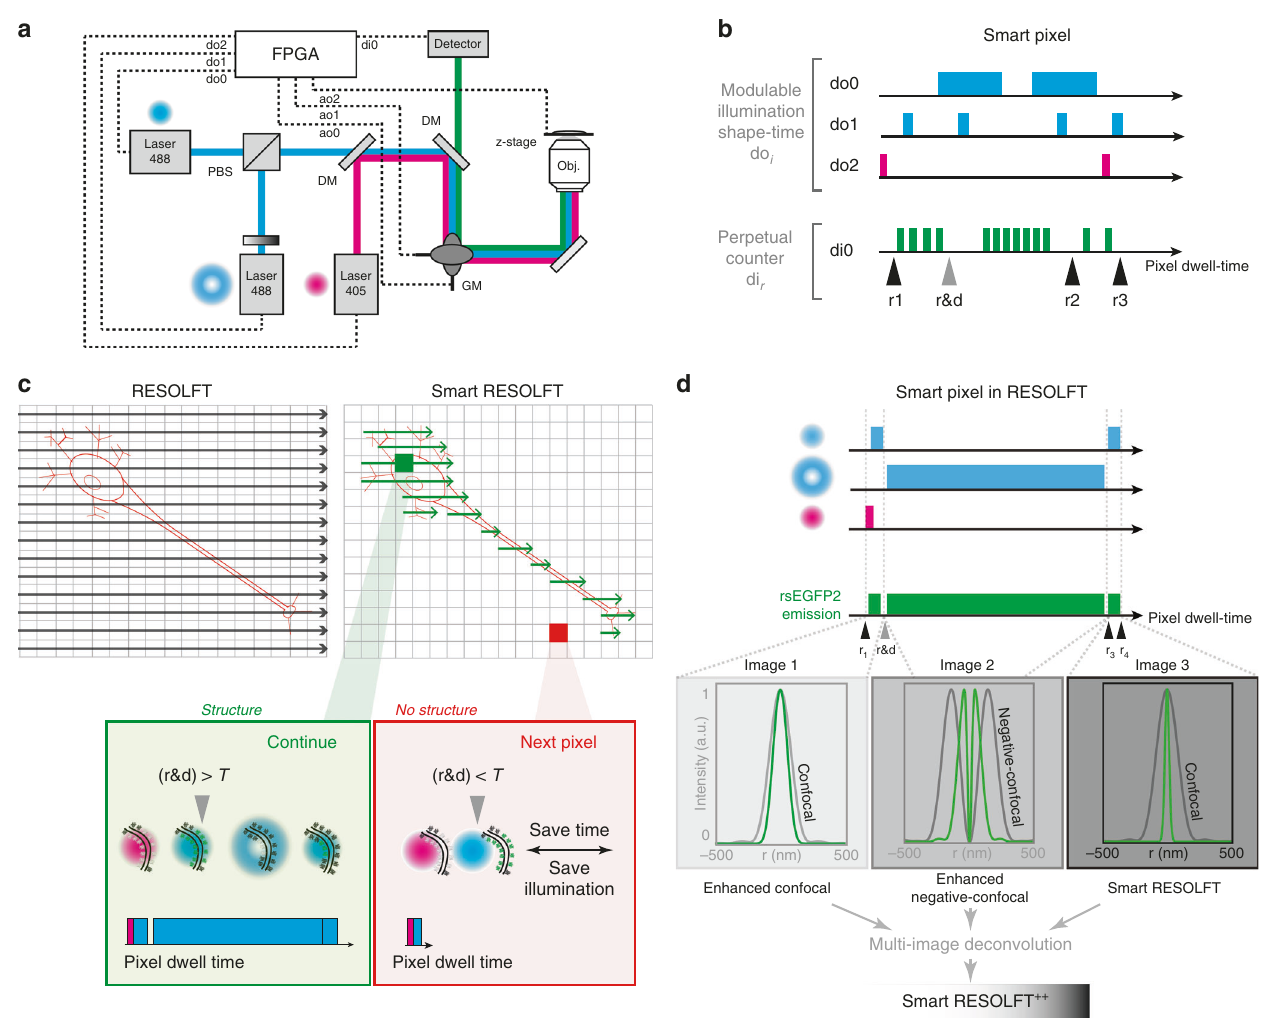
Fig. 1 Smart pixel concept in RESOLFT imaging. a Hardware scheme of the smart RESOLFT sample-adaptive set-up. The fi eld-programmable-gate-array card enables a rapid feedback loop between illumination, detection and scanning system. Multiple illumination lines, up to fi ve digital outputs do i modulate up to fi ve illuminations, which can change in shape and/or colors. The control software/hardware named Carma syncronizes the scanning architecture and the illuminations with three different analog output ao i , and with the photon detection device di 1 . b Schematic illustration of the fl exible illumination and signal registration of Carma. The combination of real-time adaptive illumination and time binned detection is named smart pixel since it is applied on the very same sample region. The number and the duration of the illumination pulses and the width of signal classi fi cation windows can be fl exibly adjusted. In particular, Carma implements a perpetual counter that is initialized at the start of the smart-pixel. Up to fi ve different read-out points r i can be introduced within the deterministic pixel-dwell time. By calculating the difference between two consecutive read-out windows, it is possible to classify the photons collected under a speci fi c illumination. The read-out points coincide with the activation/deactivation of the laser beams. The read-out window named r&d is introduced to implement the threshold-based detection for the real-time feedback system. c Raster (left) compared to smart (right) scanning, which is specimen-adaptive. The feedback loop and smart pixel technologies enable to perform RESOLFT imaging only in regions of the specimen containing labeled structures. The decision in smart RESOLFT (red and green boxes) is performed intra-pixel and it is threshold based. d Smart pixel in RESOLFT. The fl uorescence photons are classi fi ed in three separated detection windows corresponding to the probing, doughnut (OFF-switching) and read-out illumination. In conventional RESOLFT only the windows corresponding to the read-out illumination ( r 4 − r 3 ) is recorded. Here, we combine the signal generated by the three windows through a multi-image deconvolution to generate an image of higher quality. RESOLFT REversible